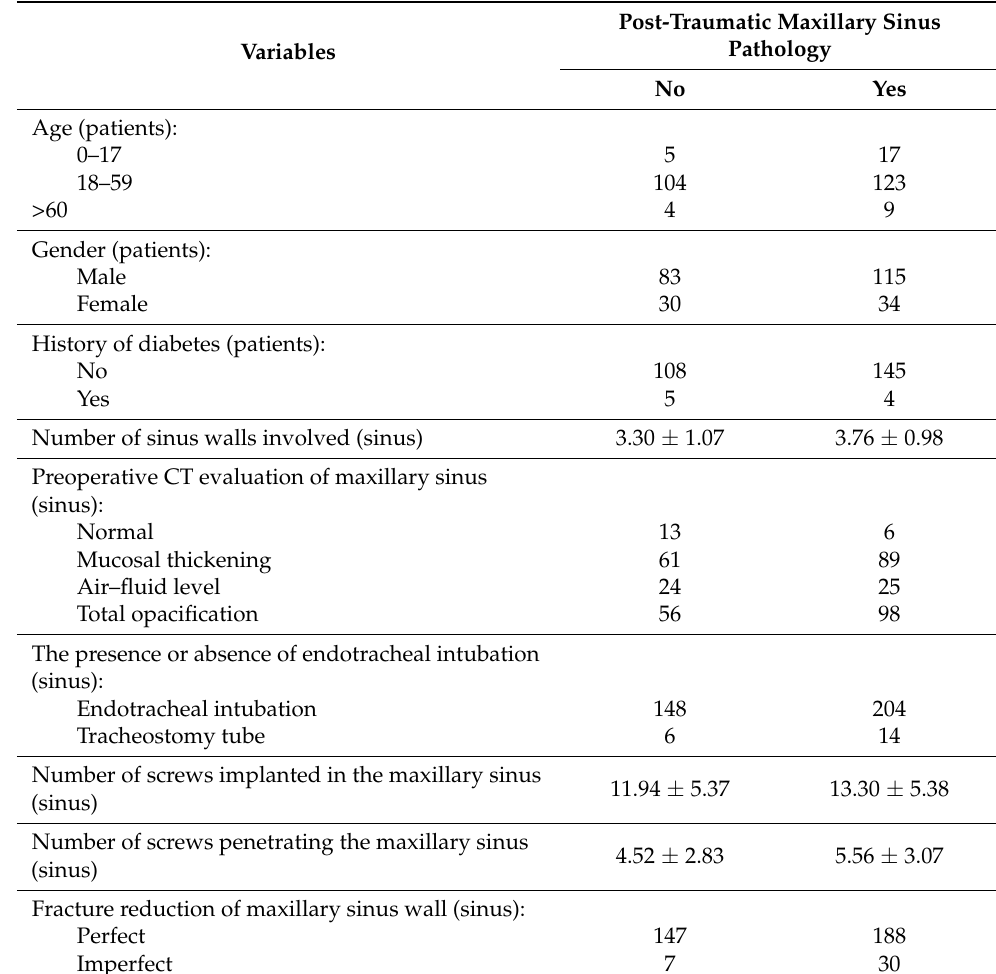
Table 2. Patient and radiological